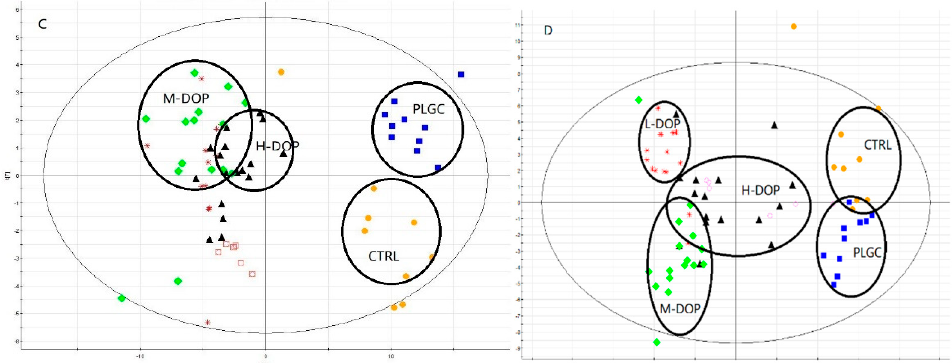
Figure 4. PLS-DA analysis between different groups in positive and negative ion pattern. After the component identification was completed, the identified data was imported into the Ezinfo software for partial least squares-discriminant analysis (PLS-DA) analysis, the circle showed that they tend to be grouped together in the PLS-DA analysis, and could be separated between each groups of observations, then cited there have the change in PLGC group ( A , B ). After treatment with DOP ( C , D ), the gather was changed, which indicated that the endogenous metabolites could be di ff erent from the PLGC group.